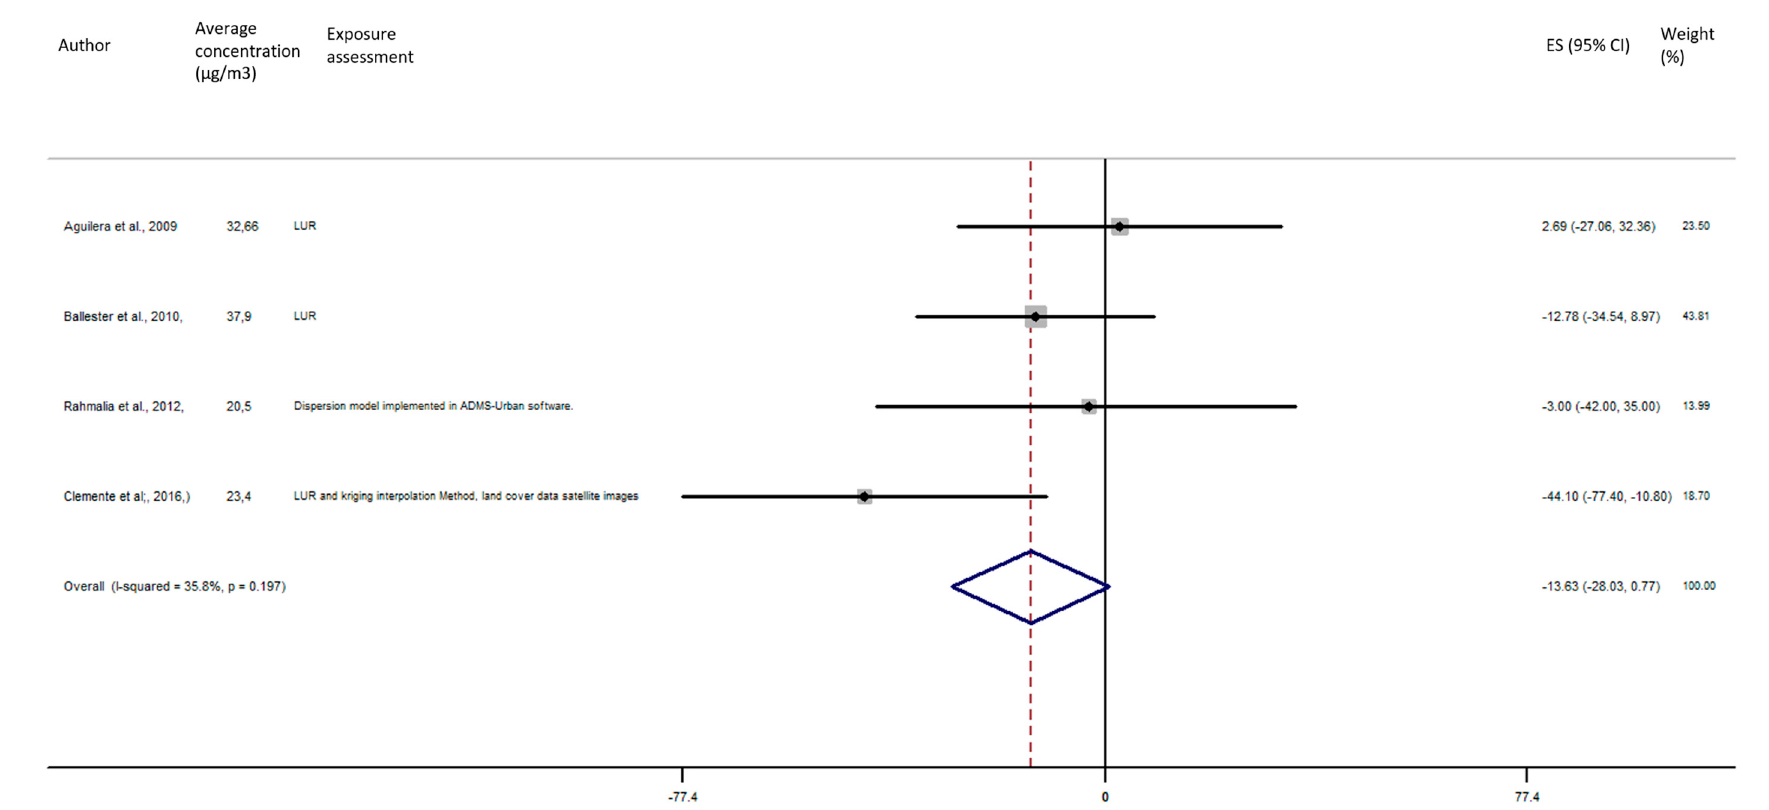
Figure 5. Association between birth weight and NO 2 exposure during the first trimester of pregnancy.